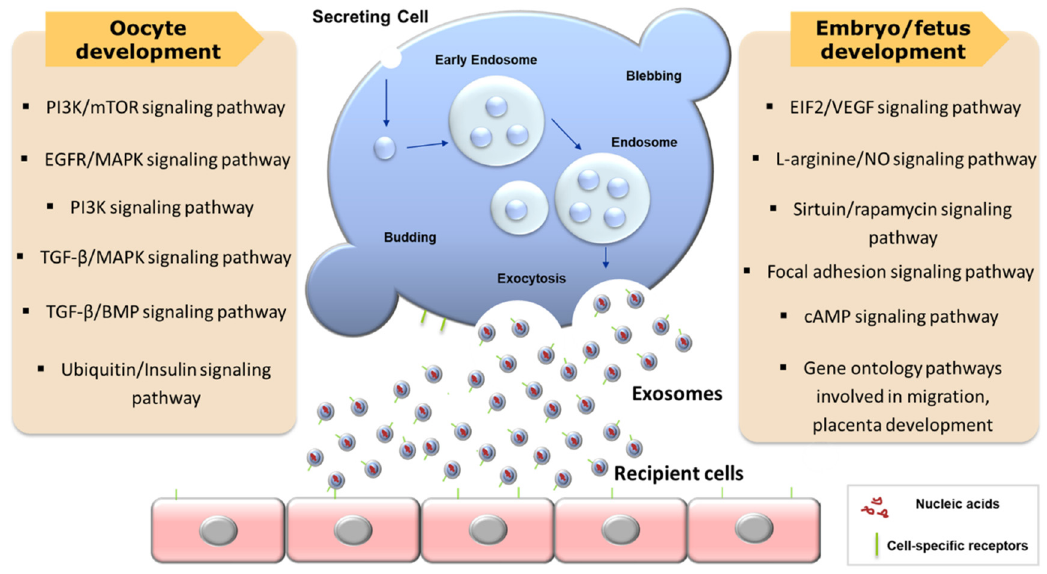
Figure Figure 2. The representative role of exosomes on signaling pathways for oocyte and embryo/fetus development.